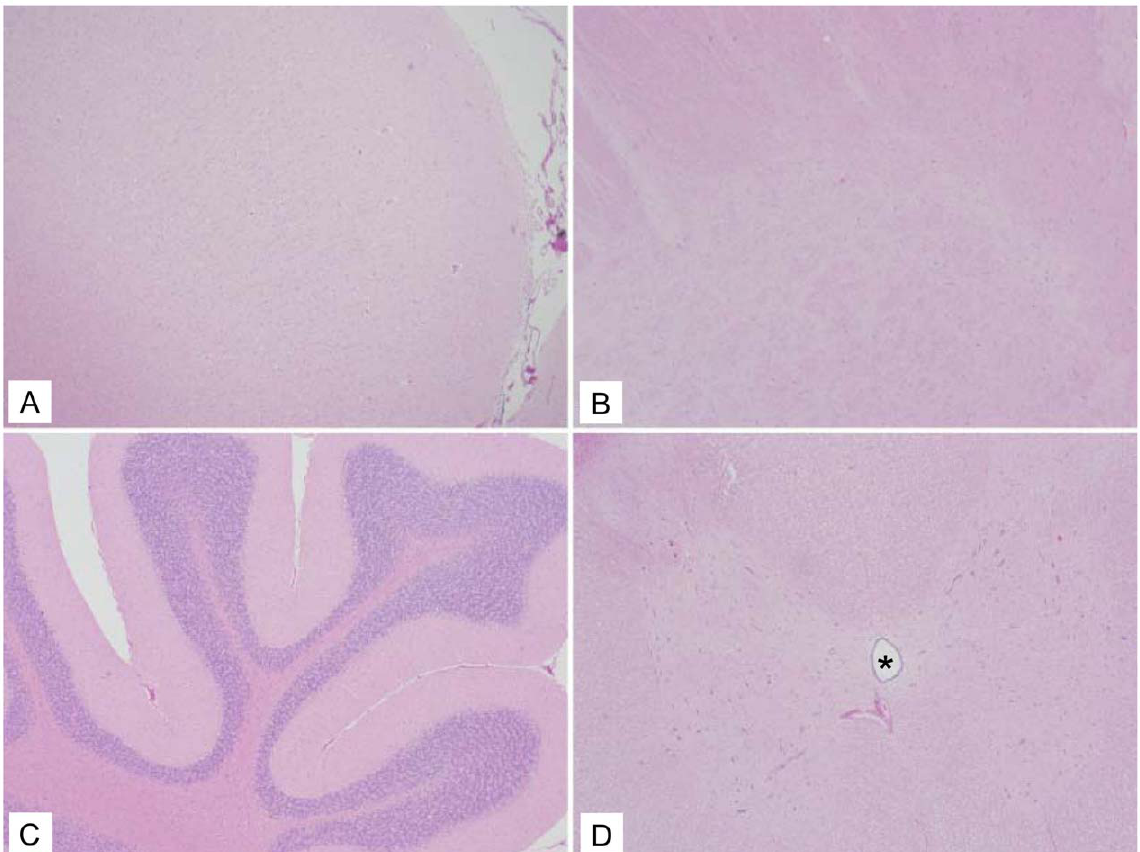
Figure 2. Representative vehicle control histology with no lesions in the neural tissue. (A) Frontal cortex (10 6 ). (B) Basal ganglia (10 6 ). (C) Cerebellum (10 6 ). (D) Spinal Cord (Asterisk denotes central canal) (10 6 ).